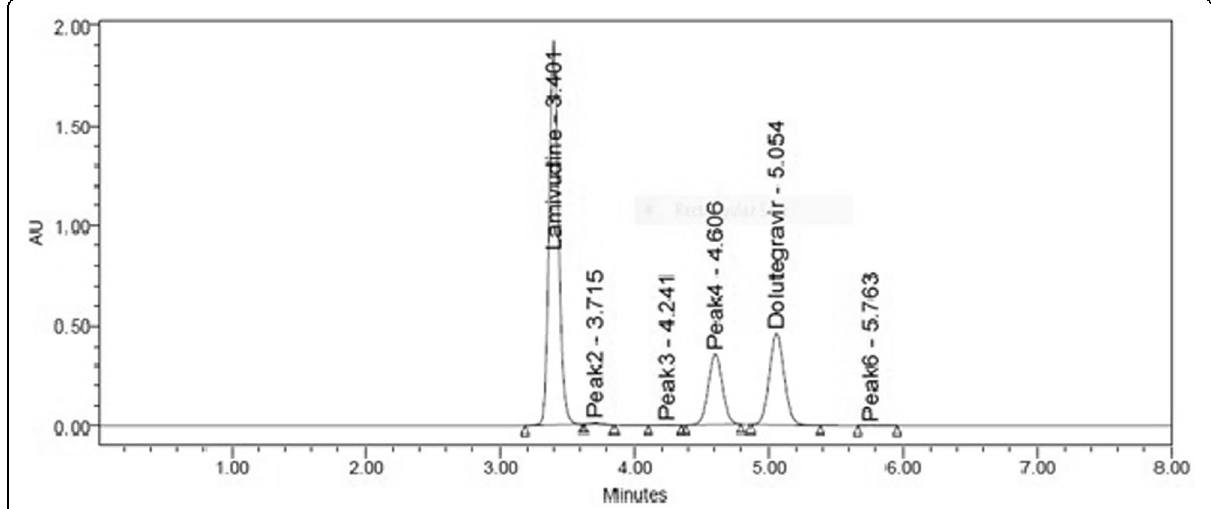
Fig. 4 Chromatogram of alkali degradation